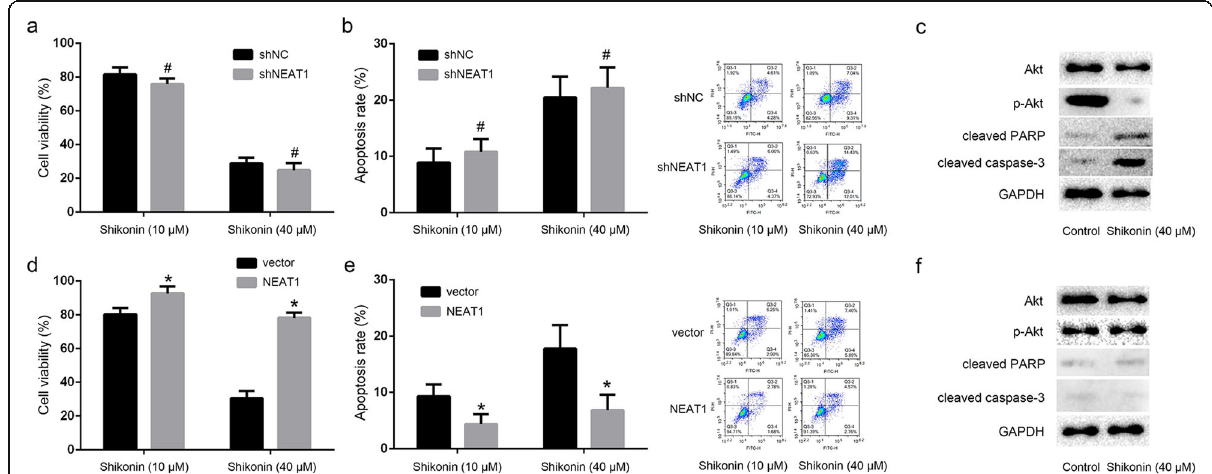
Fig. 5 NEAT1 and Akt signaling downregulation were involved in the shikonin against paclitaxel-resistant NSCLC. a Either low dose or high dose of shikonin considerably suppressed the NEAT1 knockdown A549/PTX cell growth. b Either low dose or high dose of shikonin considerably induced the cell apoptotic death in NEAT1 knockdown A549/PTX cells. c p-Akt expression was decreased, cleaved PARP and cleaved caspase-3 expression were increased after shikonin treatment in NEAT1 knockdown A549/PTX cells. d The proliferation of NEAT1 overexpression A549/PTX cells was not inhibited after shikonin treatment. e Apoptosis rates were not enhanced after shikonin treatment. f Shikonin could not decrease p- Akt expression, also could not increase cleaved PARP and cleaved caspase-3 expression after shikonin treatment in NEAT1 knockdown A549/PTX cells. *Statistically significant difference ( p < 0.05). #No statistically significant difference( p >